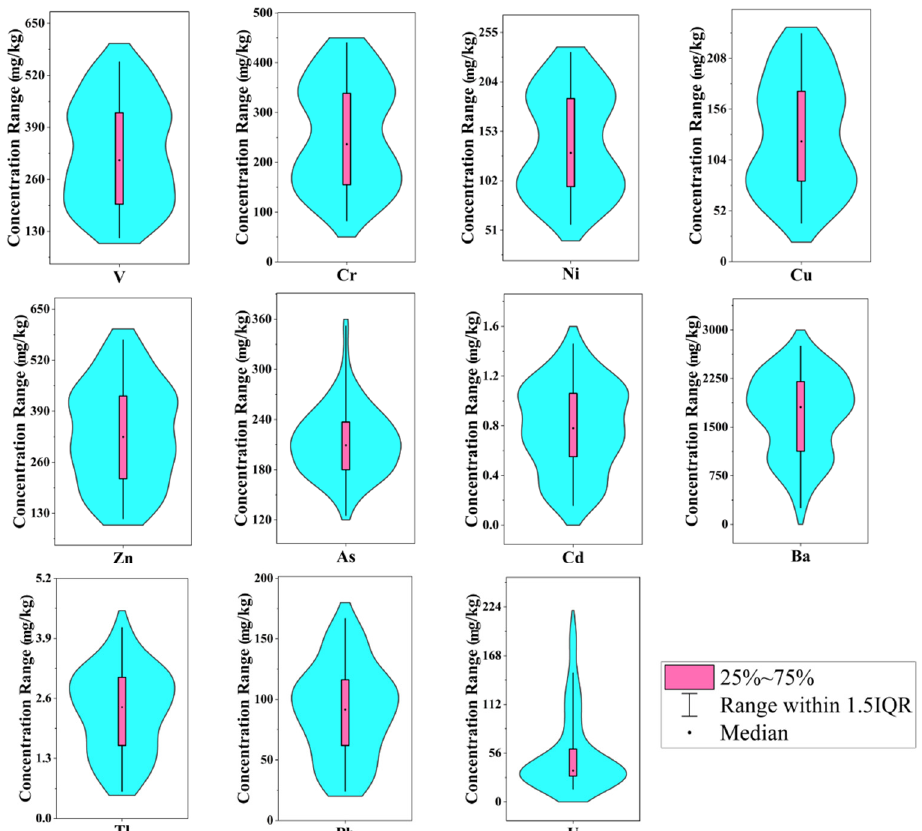
Figure 2. Violin plot with box is used to show the variations and its probability densities of trace elements (mg/kg) in the sediment of the six selected lakes in the Qaidam Basin. Note: The thick black bar in the middle represents the quarter-digit range; a thin black line extending from it indicates that it follows the 1.5IQR rule. White dot indicates the median.